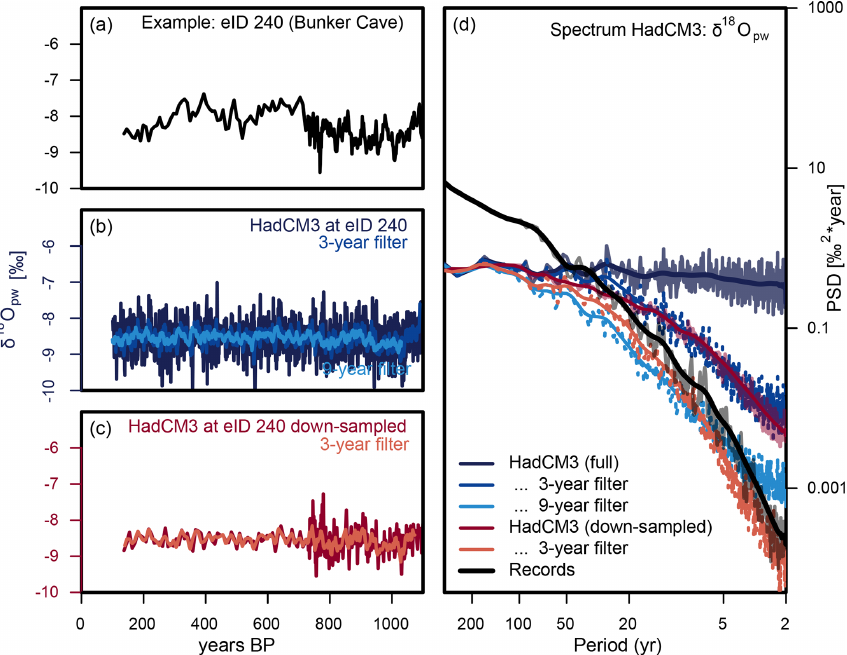
Figure 6. Variability on different timescales through comparison of measured δ 18 O dw . eq and simulated δ 18 O pw time series as well as of their spectra. (a–c) Example time series of eID 240 in Bunker cave (Germany) (Fohlmeister et al., 2012). (a) The measured δ 18 O dw . eq in the speleothem, (b) the iHadCM3 simulated δ 18 O pw at the cave location with two filters (3 and 9 years), and (c) the simulated δ 18 O pw but down-sampled to the same temporal resolution as in (a) with a 3-year filter. (d) Power spectral density (PSD) of mean spectra of simulated δ 18 O pw at the cave site in yearly resolution (blue), down-sampled to the individual record’s resolution (red), and mean spectrum of the δ 18 O dw . eq of the records (black), including the karst filter as shown in (a) – (c) . The spectra are area-weighted and averaged over the three simulations (LM1, LM2, and LM3). The colors for the example eID in (a) – (c) correspond to the colors of the mean spectra over all entities in (d)